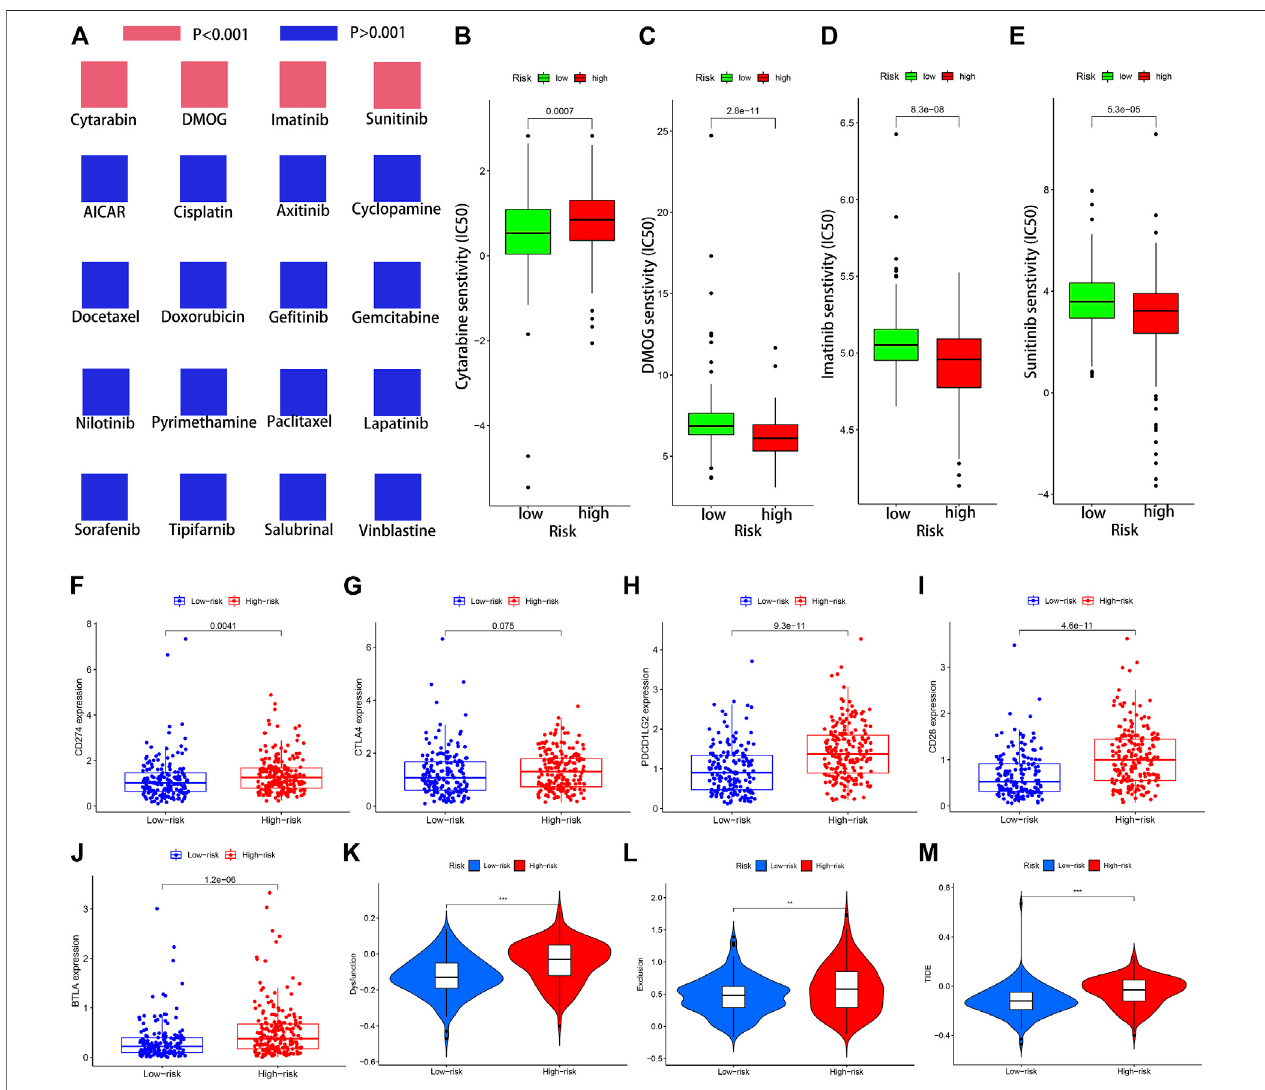
FIGURE8| Thesigni fi canceoftheNRLs-basedsignatureinchemotherapy andimmunotherapy. (A) Sensitivityperformanceof20commonchemotherapyagents in the high-risk and low-risk subsets. (B) Cytarabine, (C) DMOG, (D) Imatinib, (E) Sunitinib. (F – J) Scatter plots visualizingmarkedly differential expression ofthe immune checkpoint genes CD274, BTLA, CD28, CTLA4, and PDCD1LG2 between the high-risk and low-risk patients. Correlation of risk score and other immune-related prognostic scores. (K – M) T cell dysfunction, T cell exclusion, and TIDE score in different risk subsets. *: p < 0.05 **: p < 0.01 ***: p < 0.001.